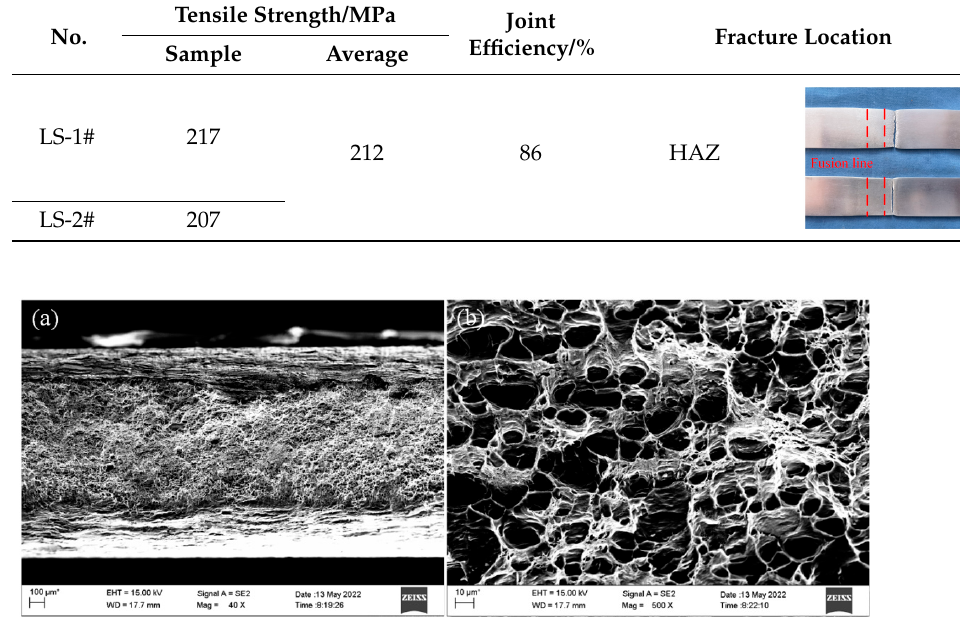
Figure 7. Fracture characteristics of the tensile specimen: ( a ) macroscopic feature; and ( b ) microscopic feature.